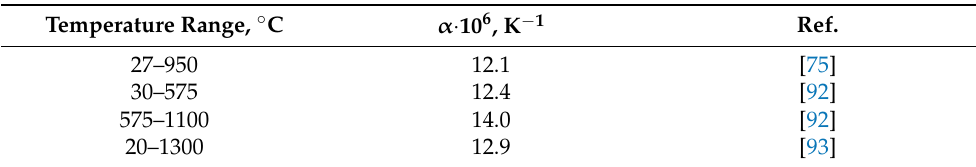
Table 2. Thermal expansion coefficients of Sr 2 NiMoO 6- δ in air. These data are also presented in Figure A1. Temperature Range, ◦ C α · 10 6 , K − 1